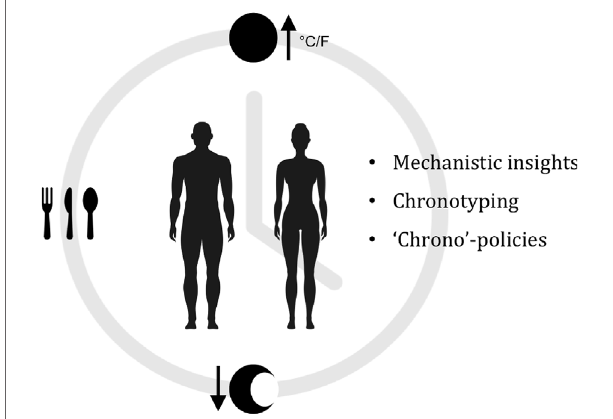
FIGURE 1 | Exploiting the circadian clock for improved cancer therapy. We are exposed to ever-changing light, temperatures, and nutrients on a daily basis. In response to these Cyclic Stimuli, our bodies modulate a wide range of physiological and cellular processes in an oscillatory manner (Chronobiology). Since chronobiology is a complex physiological phenomenon, it is currently not greatly considered as a factor in the research and development of novel anticancer drugs, nor in clinical trials. Nonetheless, recent studies have reported correlations between the circadian clock, cancer and therapy response. Giacchetti et al., 2012; Sephton et al., 2013; Lévi et al., 2014; Papagiannakopoulos et al., 2016; Ye et al., 2018. We suggest that an in-depth understanding of circadian mechanisms from single tissue types to entire systems, could potentially allow us to stratify individual patients not only by genomic and genetic aberrations in their tumors, but also by clock functions (Chronotype). this could be of great benefit and improve cancer